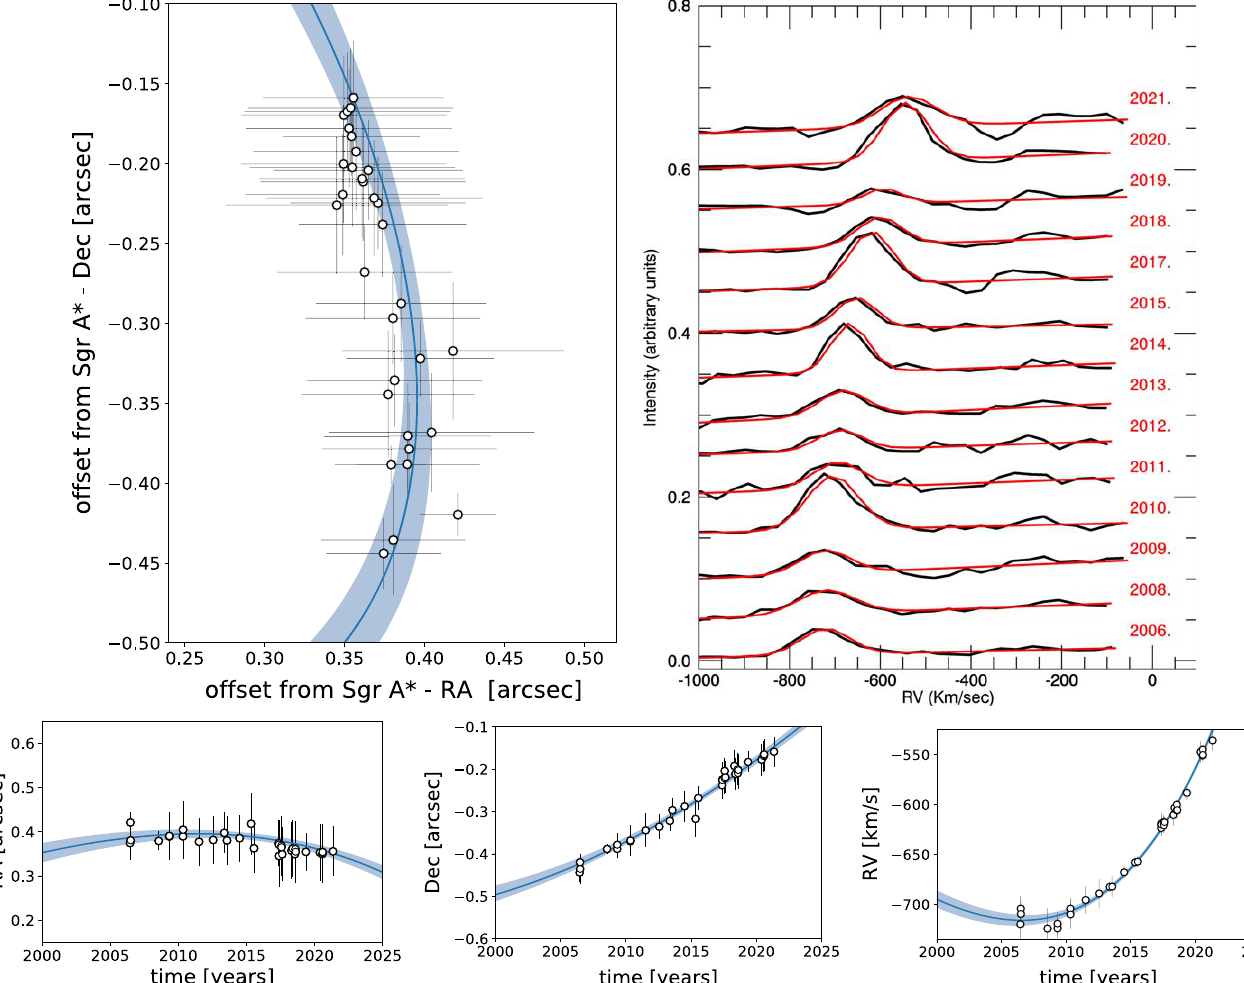
Figure 7. Orbital motion of the leading tip of X7. Top left: Orbital fi t ( blue line, with 1 σ error envelope ) superimposed on the astrometric measurements of Br- γ emission ( empty circles, obtained with OSIRIS ) . Top right: evolution of the radial velocity of the tip of X7, illustrated with a subsample of one tip spectrum per year. The blueshifted Br- γ emission line is fi tted with a Gaussian pro fi le ( red curve ) to extract the tip ’ s radial velocity. Bottom: astrometry ( R.A. and decl. are reported as offsets from Sgr A * , with positive offsets westward ) and radial velocity fi t for the leading tip of X7. Measurements and their uncertainties ( in black ) are compared to the resulting orbit model ( with 1 σ error envelopes in light blue ) . All data points are consistent with the orbit model to within 2 σ . Table 4 Keplerian Orbital Parameters of the X7 Tip, Based on OSIRIS Data Only Eccentricity 0.34 ± 0.05